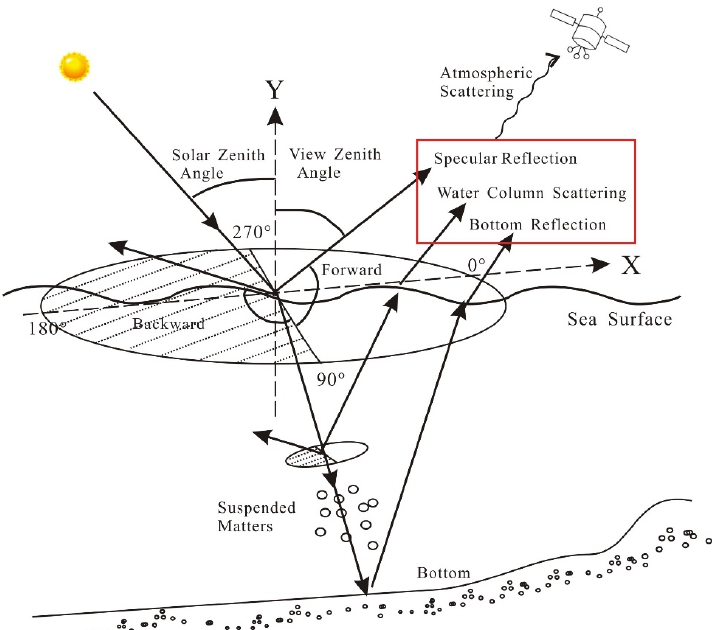
Figure 3. The reflectance just above the water surface ( R ap ) gathered by the sensor includes three parts, namely, the specular reflection ( R sg ), the water column scattering ( R rs ), and the bottom reflectance ( R bw